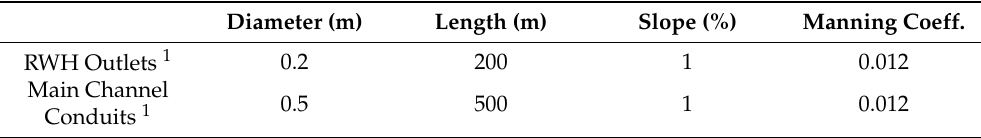
Figure 2. Modeled drainage system with the corresponding inflows and outflows from the rainwater tanks. Overflows and controlled releases both flow through the tank outlets. Table 1. Hydraulic characteristics of the modeled drainage system